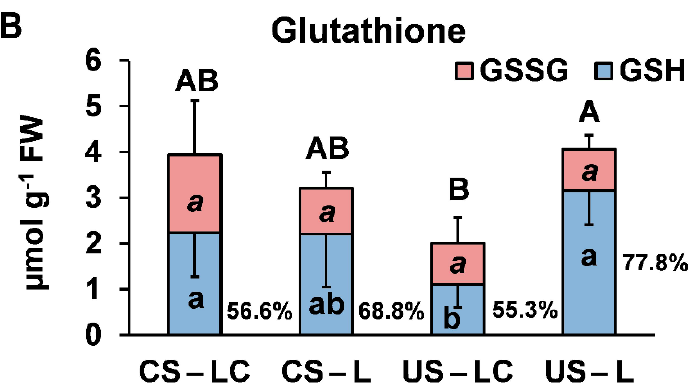
Figure 6. Reduced (AsA) and oxidized (DAsA) ascorbate contents ( A ) and reduced (GSH) and oxidized (GSSG) glutathione contents ( B ) in shoots of L. pedunculata grown from São Domingos seeds (LC) and Caldeirão seeds (L) planted in the contaminated soil from São Domingos (CS) and the uncontaminated soil from Caldeirão (US) (average ± standard error; n = 4). Percentage reduction of AsA and GSH are shown in each corresponding graph. Different letters—lowercase (AsA and GSH), italic (DAsA and GSSG) and uppercase (total ascorbate and total glutathione)—indicate significant differences among soil/plant treatments ( p < 0.05).